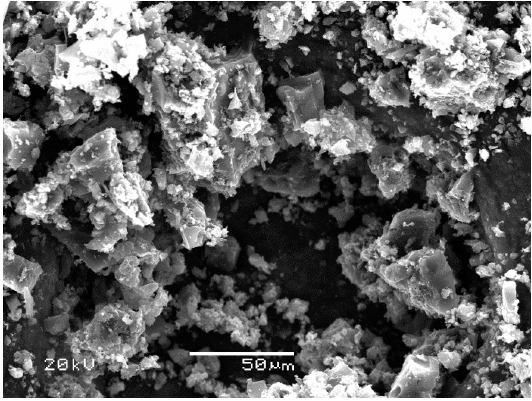
Figure 2. SEM images of adsorbent at a magnification of 500×.